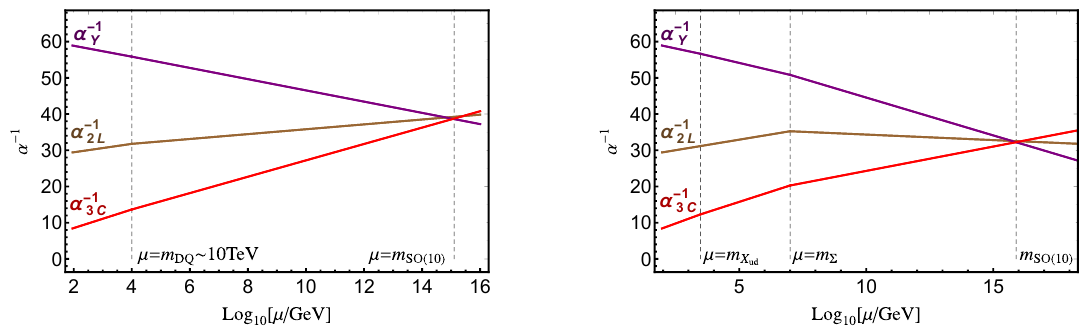
Figure 21 . Evolution of SM gauge couplings with a colour sextet X ud and two copies of ∆ : (1 , 3 , 0) both around the TeV scale (left) , or a colour sextet X at the TeV scale and a SU(2) triplet field ud L (cid:1) at an intermediate scale Σ : (cid:0) 6 , 3 , 1 (right) demonstrating a possible gauge coupling 3